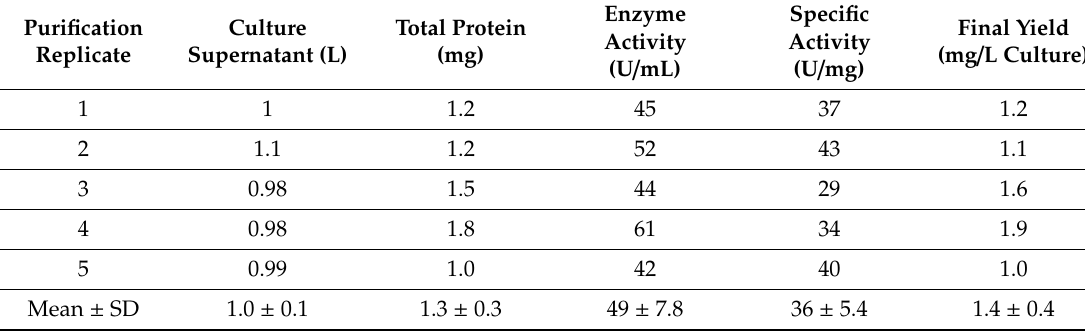
Table 2. DPP4 purification yields and specific activity from five replicate experiments.